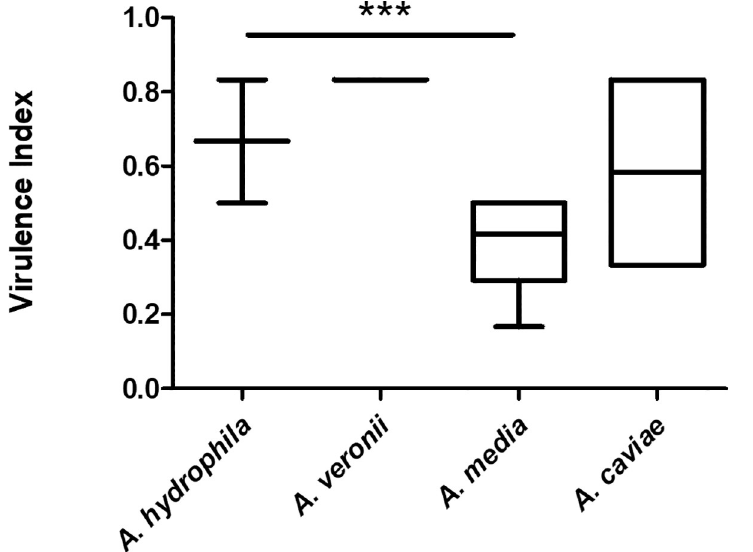
Fig 4. Virulence index by Aeromonas species. ��� —p < 0.001.